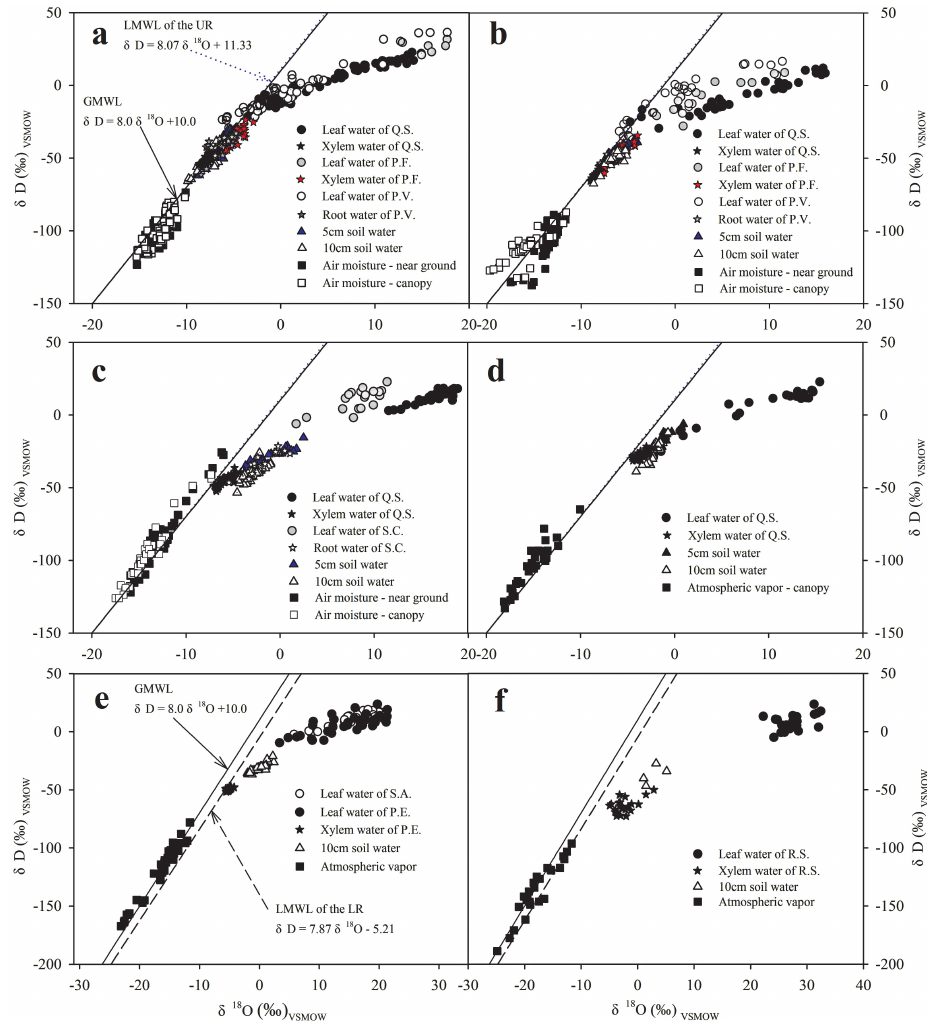
Figure 3. Plot of δ D and δ 18 O of different water pools at each site. The LMWL (cited from He, 2011) is plotted for each site (the dark line is the GMWL (the global meteoric water line); the blue dotted line and the dashed lines are the LMWL of the upper and the lower reaches, respectively). Note: panels (a) , (b) , (c) , (d) , (e) and (f) refer to the same location as in Fig. 2, and the abbreviations of plant Latin names are the same as in Table